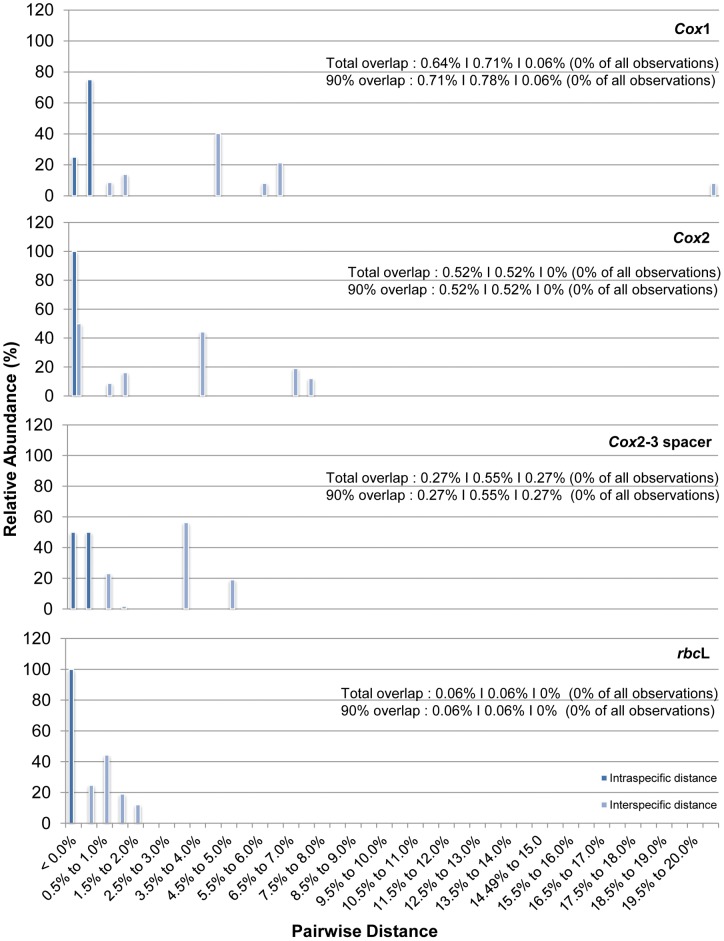
Plot of intra- and interspecific genetic distances for the cox1, cox2, cox2-3 spacer and rbcL DNA markers.Numeric values are arranged according to: the difference between the smallest interspecific but intrageneric distance and the largest intraspecific distance|smallest pairwise distance between interspecific but intrageneic sequences|largest pairwise distance between intraspecific sequences; followed by the number of observations affected (in brackets).